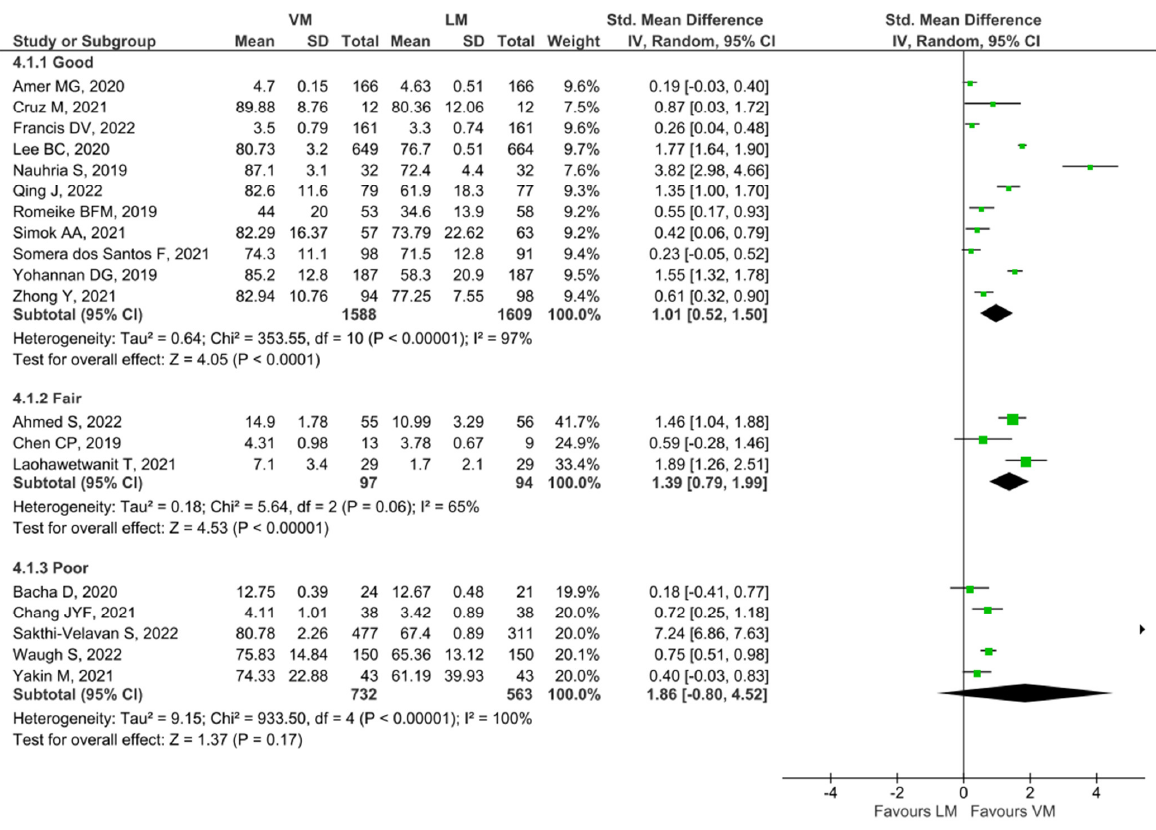
Figure 5. Analysis of studies based on NOS scale quality [20,31–35,37–39,44,45,50,52,57–60,63,64]. In sum, 11/19 studies were categorized as good quality, whereas 3/19 were fair and 5/19 were of poor quality. The result showed a clear significance for the “good” subgroup (SMD: 1.01 [95% CI: 0.52, 1.50], p < 0.001) as well as the “fair” subgroup (SMD: 1.39 [95% CI: 0.79, 1.99], p < 0.001). The result was not significant for the “poor” rated studies (SMD: 1.86 [95% CI: −0.80, 4.52], p = 0.17). The studies in the funnel plot are distributed asymmetrically, which suggests publication bias. Begg’s and Mazumdar’s for rank correlation have a p -value of 0.19, suggesting publication bias. Eggers test for a regression intercept of 10.36 resulted in p - value (one-tailed) of 0.06, which confirms the presence of publication bias (Figure 6).